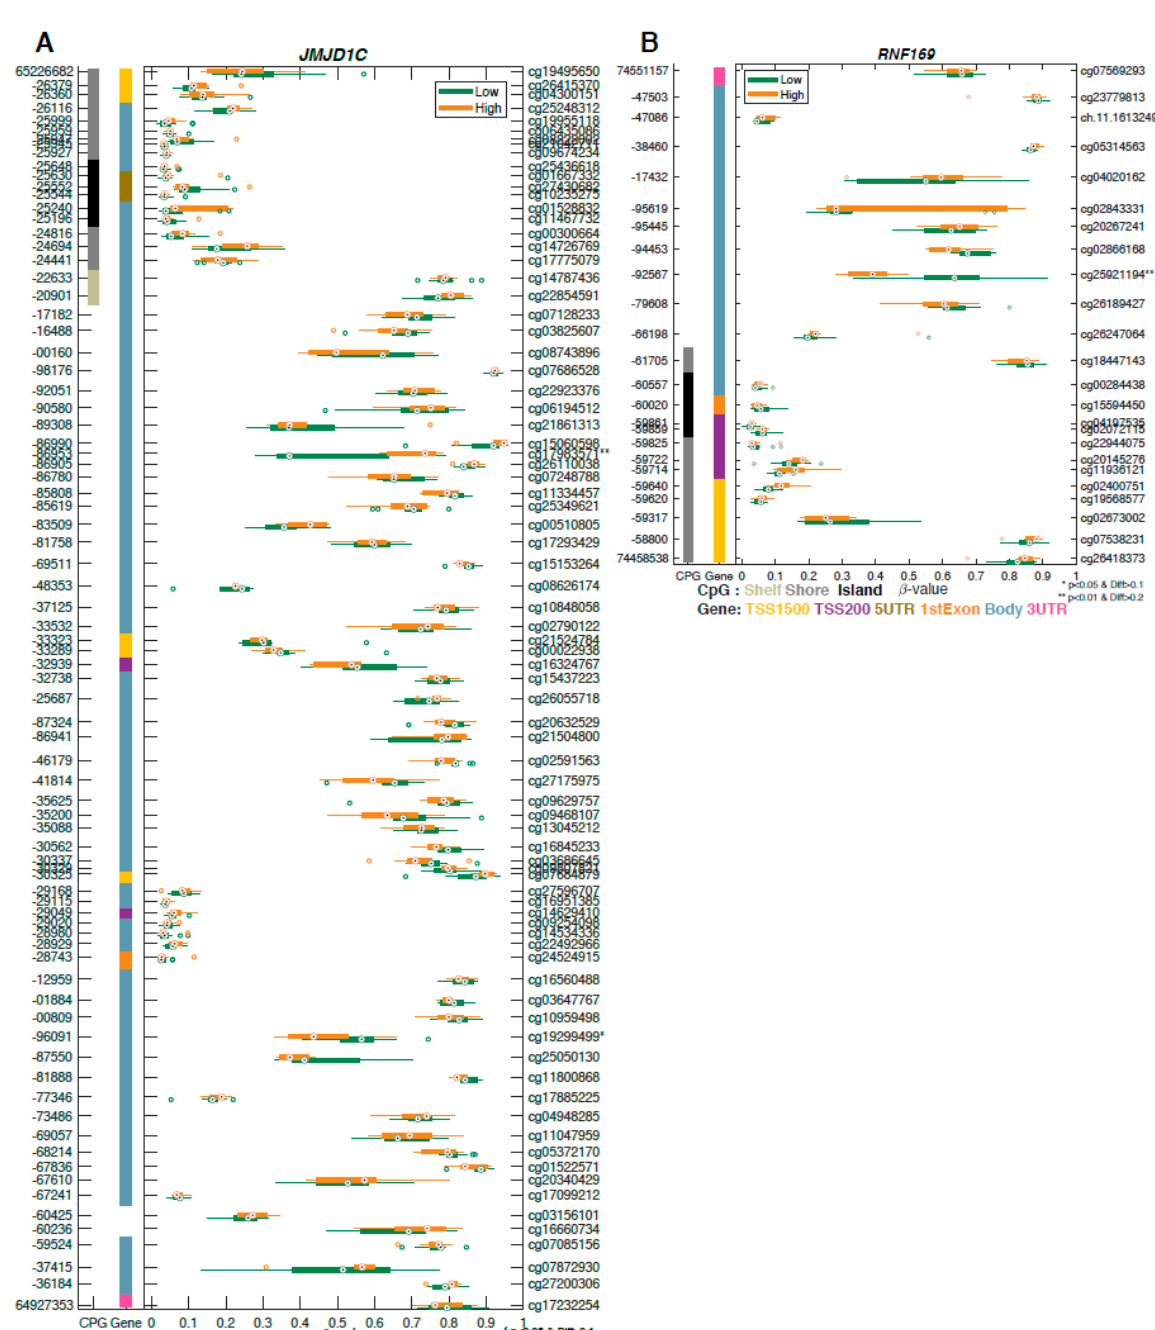
Figure 3. Two differentially methylated DNA repair genes associated with aggressiveness were found to contain probes with significant changes in methylation. GSM plots for ( A ) JMJDC1 and ( B ) RNF169 are